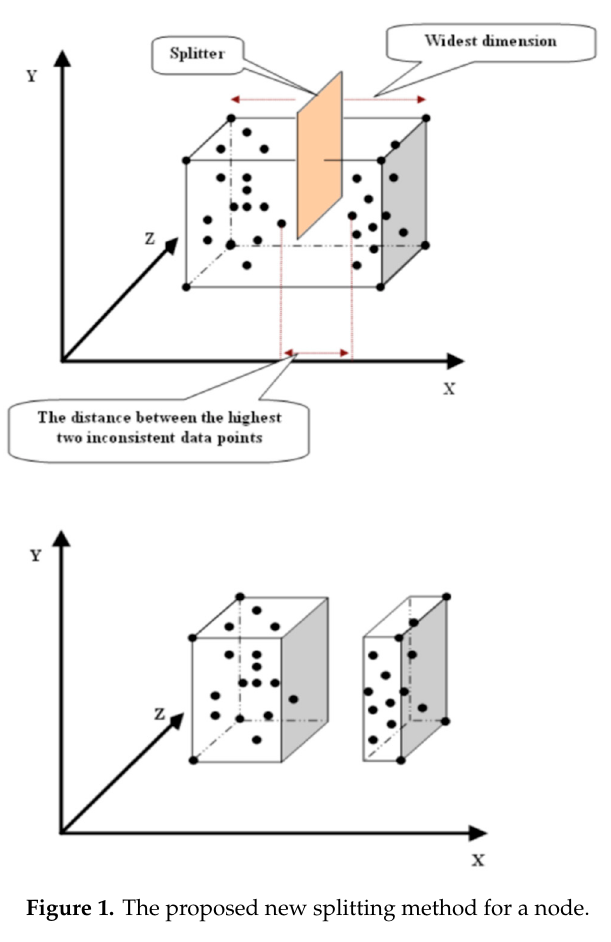
Figure 1. The proposed new splitting method for a node.